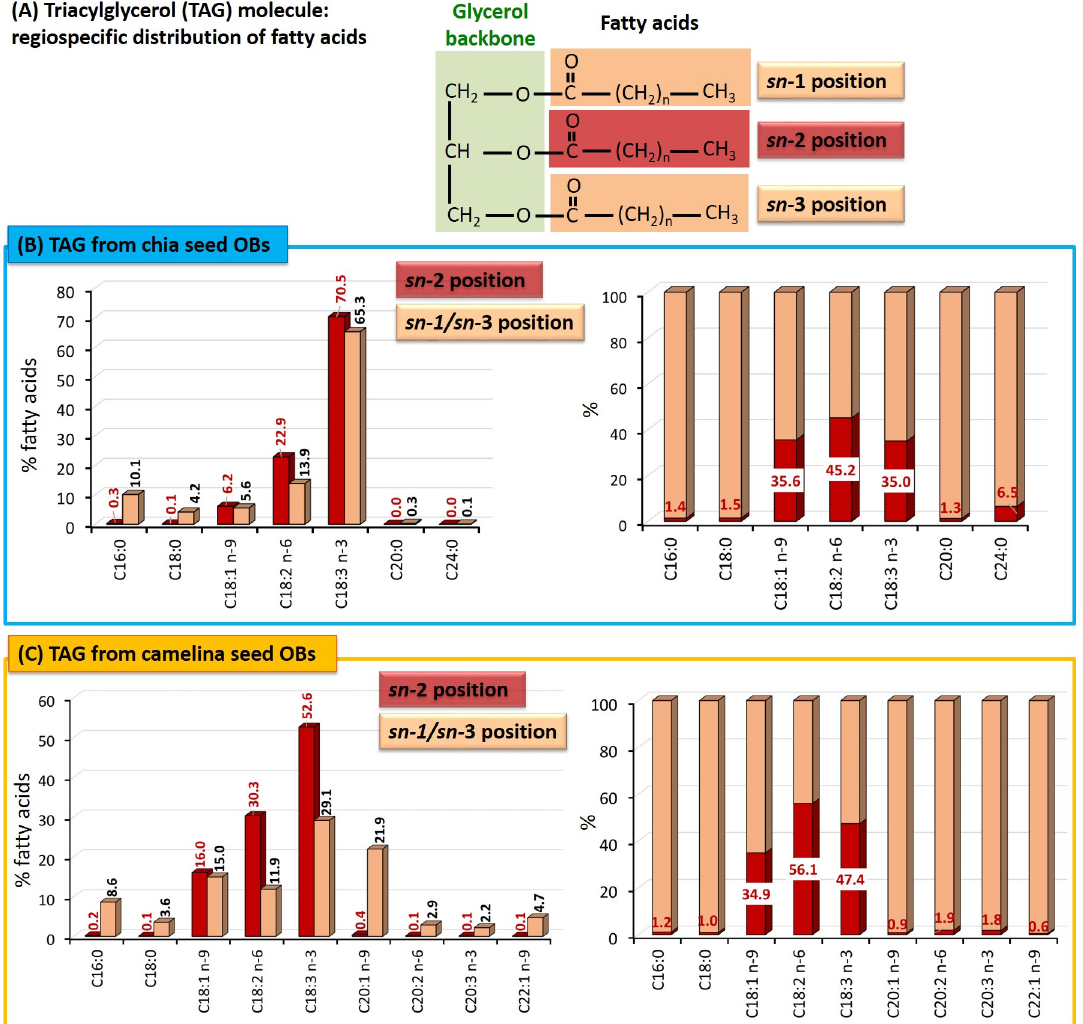
Figure 6. Regiospecific distribution of the fatty acids in the triacylglycerols (TAG) from chia and camelina seed oil bodies (OBs). ( A ) Schematic representation of a TAG molecule showing the central sn- 2 position and the external sn- 1 and sn- 3 positions. ( B ) TAGs from chia seed OBs; left: relative proportion of the fatty acids in the sn- 2 position and in the sn- 1/3 positions (% total fatty acids in the same position); right: relative distribution of each fatty acid in the sn- 2 and sn- 1/3 positions; ( C ) TAGs from camelina seed OBs; left: relative proportion of the fatty acids in the sn- 2 position and in the sn- 1/3 positions (% total fatty acids in the same position); right: relative distribution of each fatty acid in the sn- 2 and sn- 1/3 positions.